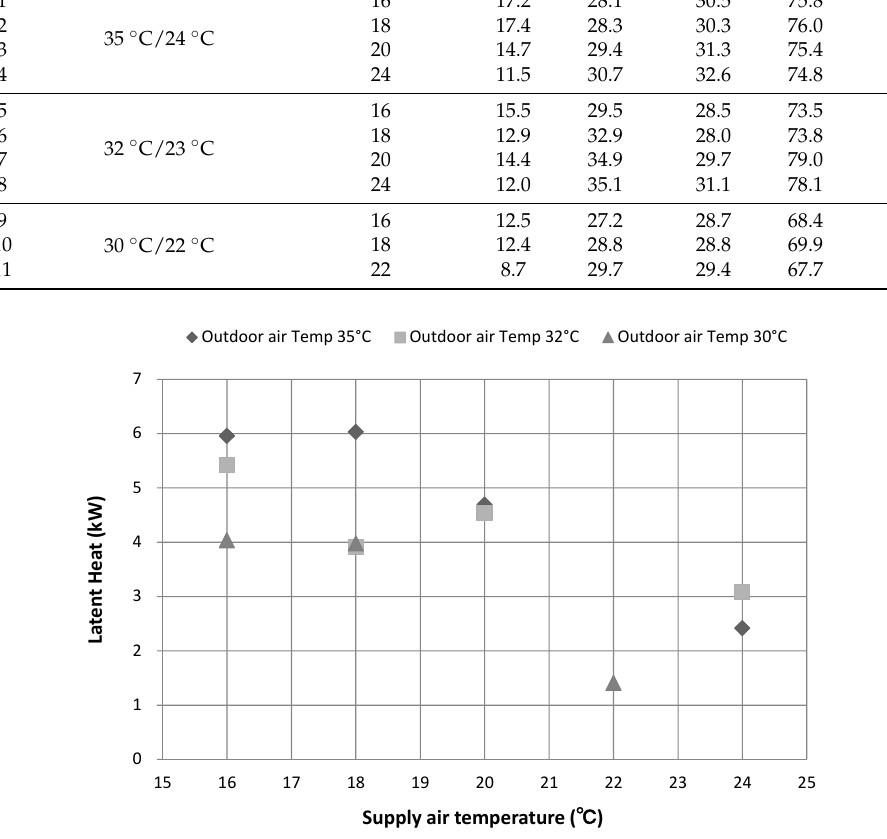
Figure 3. Changes in latent heat processing amount in the OAP according to supply air temperature.